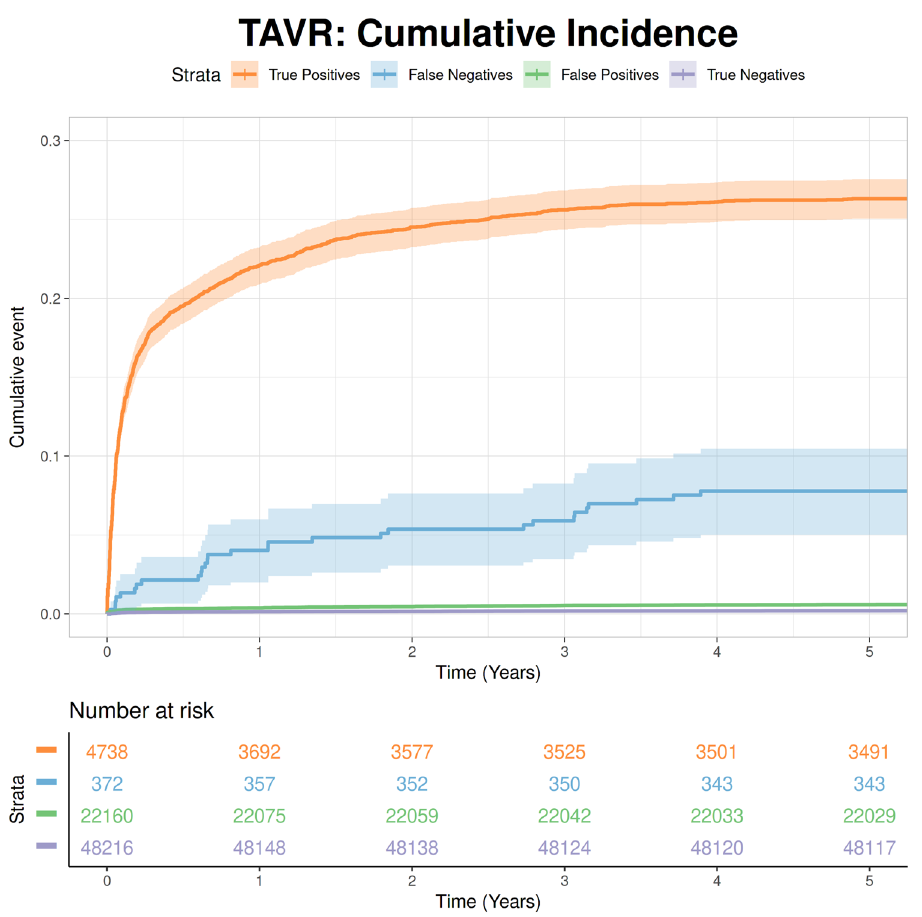
Fig. 6 Cumulative incidence of Transcatheter Aortic Valve Replacement (TAVR) by model prediction. Atrisknumbersrepresentmultiplepredictionspaired to each TAVR procedure for each patient prior to the date of the procedure. Shaded area around curve represents con fi dence interval. Follow up interval: 5 years.